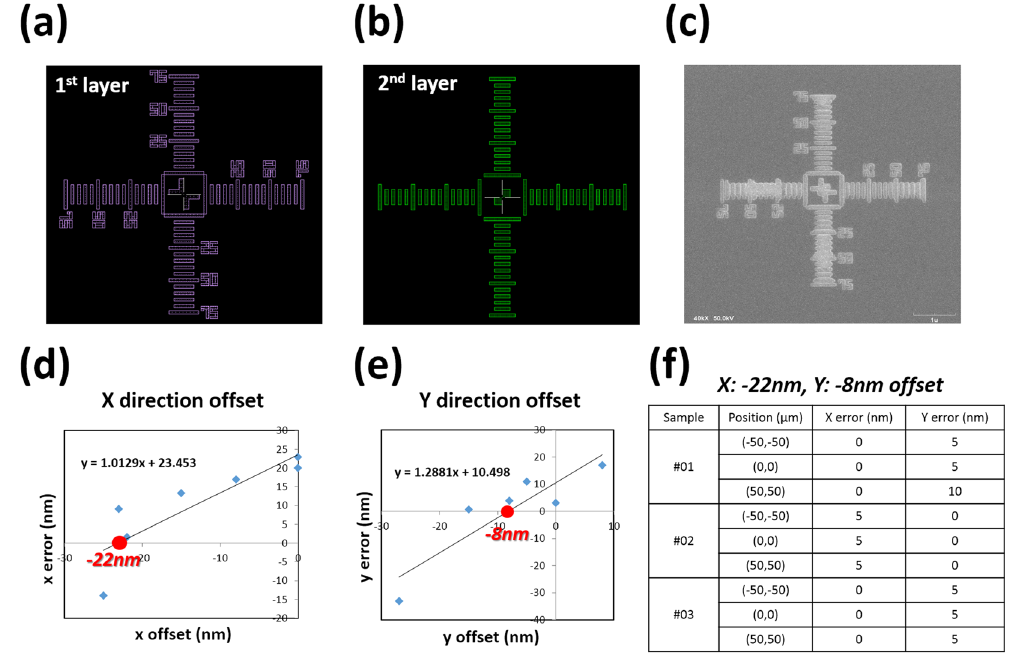
Figure 3. Alignment calibrator (nano-ruler). In order to compensate for alignment errors caused by mechanical errors (e.g. stage movement) we design a calibrator and measure the alignment errors. ( a , b ) The calibrator of the first and the second layer, respectively. ( c ) SEM image of a fabricated calibrator. The calibrator or ruler is used to measure alignment errors and each scale on the ruler represents 50 nm. After making the first layer calibrator structures, we can fabricate the second pattern on top of the first calibrator. If there are no alignment errors, then the second patterns should fit onto the first pattern exactly. Thus, by observing the fabricated patterns, we can find the proper offset to compensate for the alignment errors induced by mechanical errors. ( d , e ) Statistical results of the translational errors. By applying offset properly into the mask (CAD pattern) design, we can find the intrinsic alignment errors that occur from the EBL system. ( f ) Error data set after imposing the optimum offset. We test three samples and three alignment processes are done at different positions on each sample. Measured errors are sub-20